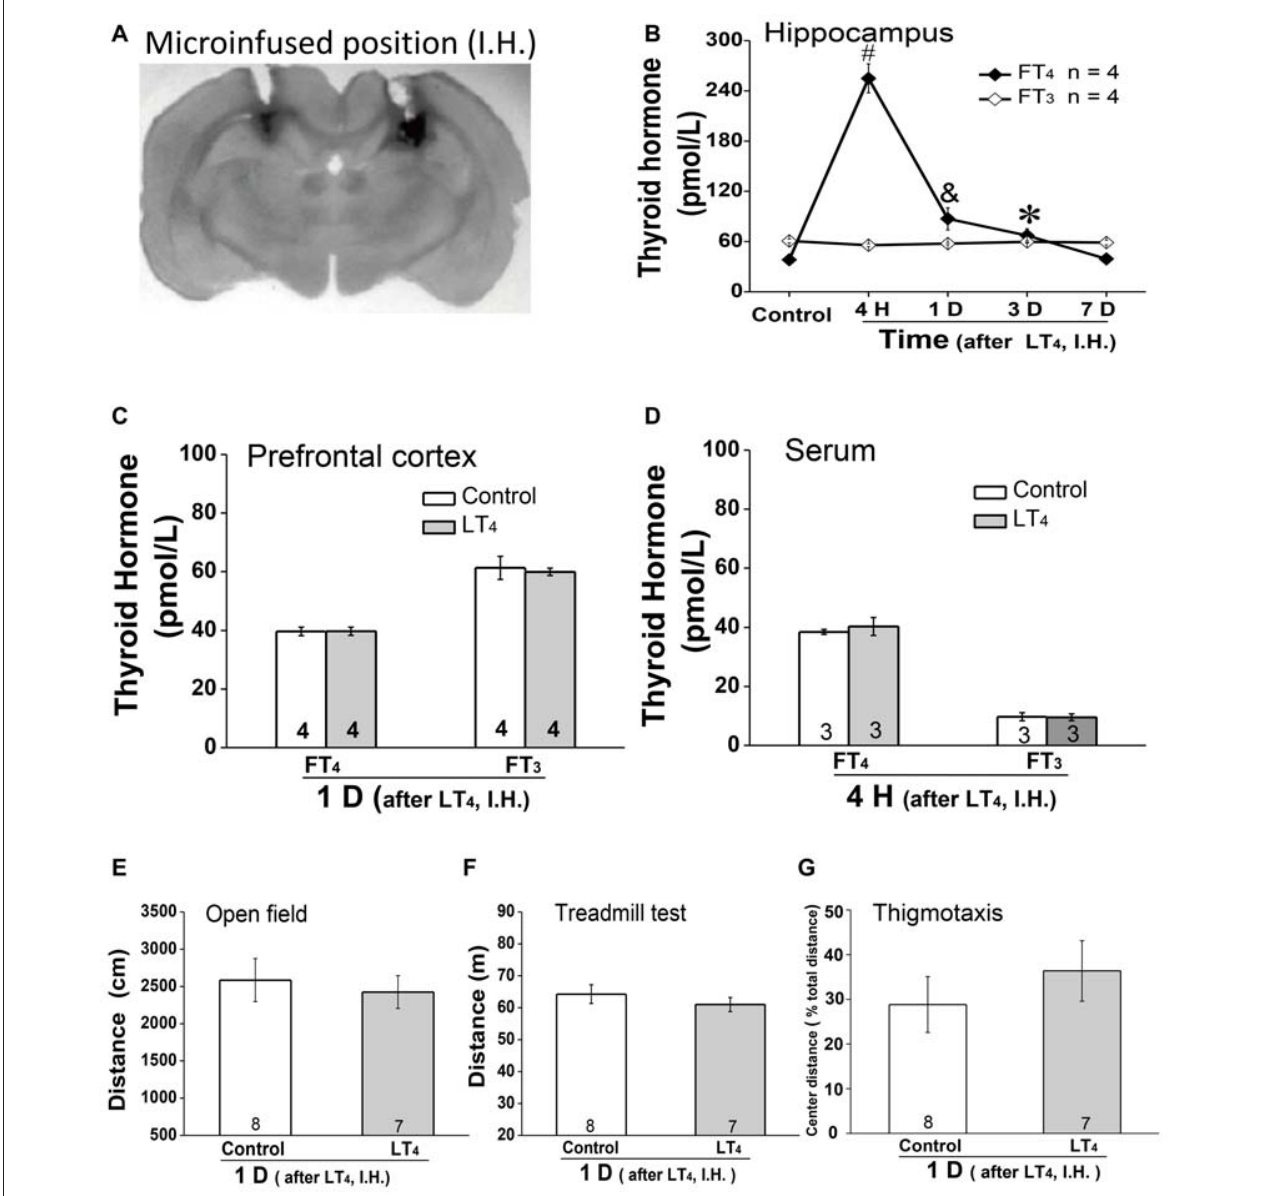
FIGURE 2 | Effects of intrahippocampal injection of LT 4 on free THs in hippocampus, prefrontal cortex (PFC) and serum, locomotor activity and thigmotaxis. (A) The position of the trypan blue-stained area was the histological demonstration of cannula tracts and the typical location for delivery of LT 4 to hippocampus. (B) The time course of hippocampal THs concentration after hippocampal injection of LT 4 (0.4 µ g/ µ l, 1 µ l/side). (C) The THs concentration in PFC 1 day after hippocampal injection of LT 4 . (D) The THs concentration in serum 4 h after hippocampal injection of LT 4 . (E) The open field test 1 day after hippocampal injection of LT 4 . (F) The treadmill test 1 day after hippocampal injection of LT 4 . (G) The thigmotaxis 1 day after hippocampal injection of LT 4 . Numbers in bars represent animal numbers.